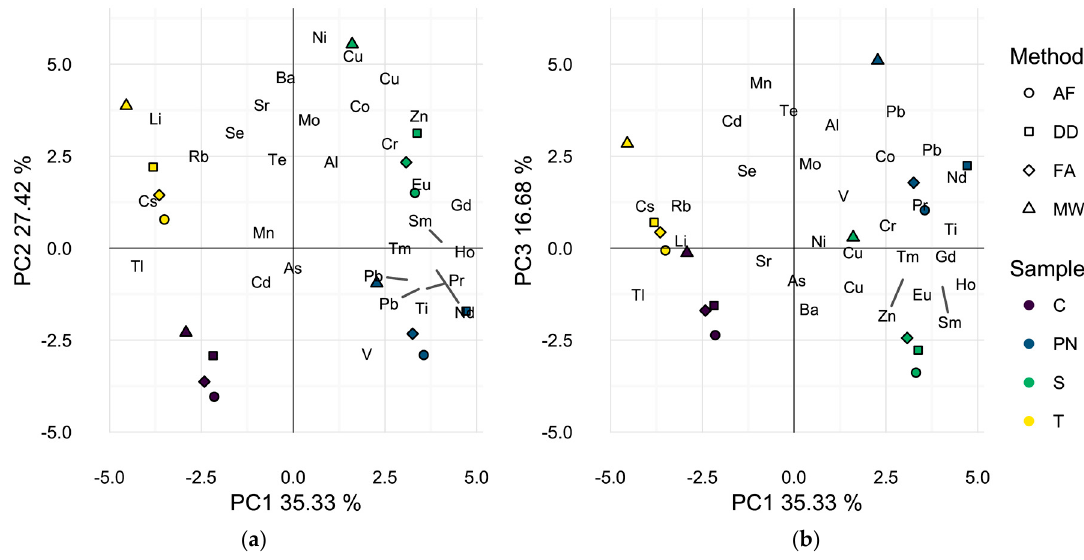
Figure 2. Principal component analysis biplots of wine scores and analyte loadings for each sample found to differ by preparation method with seven additional elements removed. ( a ) First two dimensions (62.8% of total variance); ( b ) first and third dimensions (52.0% of total variance). Symbols represent different preparation methods: acidification prior to filtration (AF = ○ ); direct dilution (DD = □ ); filtration prior to acidification (FA = ◊ ); microwave digestion (MW = △ ). Wine varieties are color-coded: Chardonnay (C = purple), Pinot noir (PN = blue), Syrah (S = green), and Tempranillo (T = yellow).